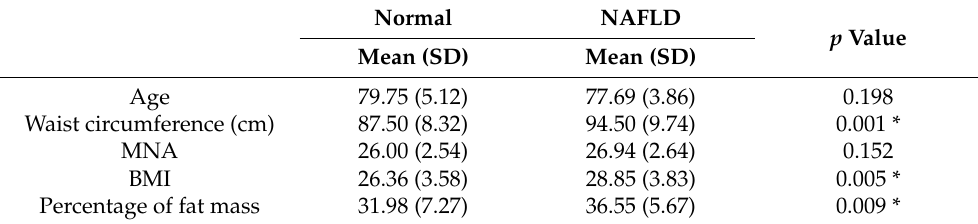
Table 2. Association of variables with NAFLD presence.